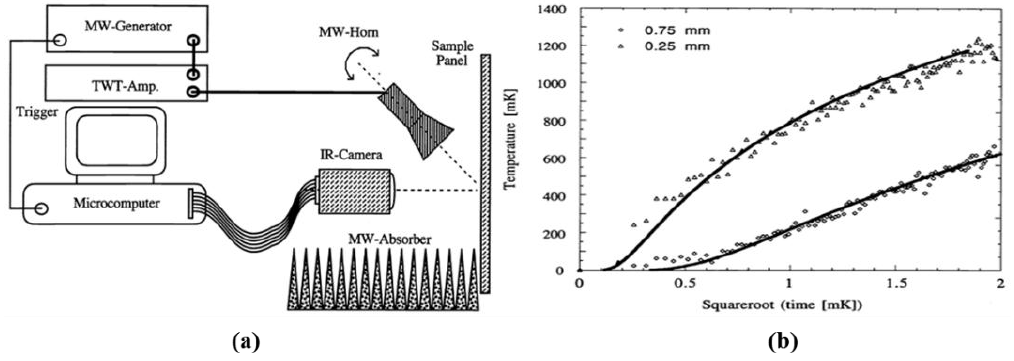
Figure 19. Schematic diagram of the experimental setup in The John Hopkins University ( a ) and